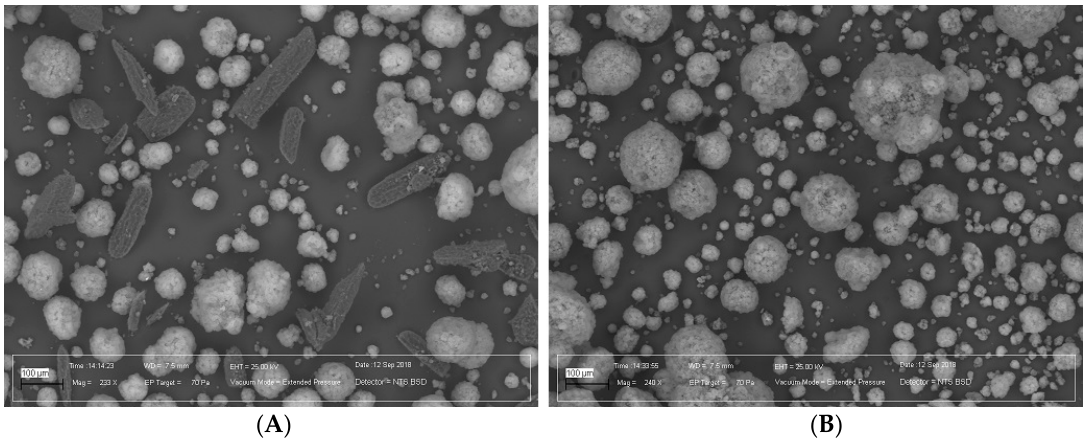
Figure 5. SEM images of ( A ) the unprocessed physical mixture (IBU 50%, Neusilin 50%) and ( B ) the HMI extrudate. Magnification: 144×.